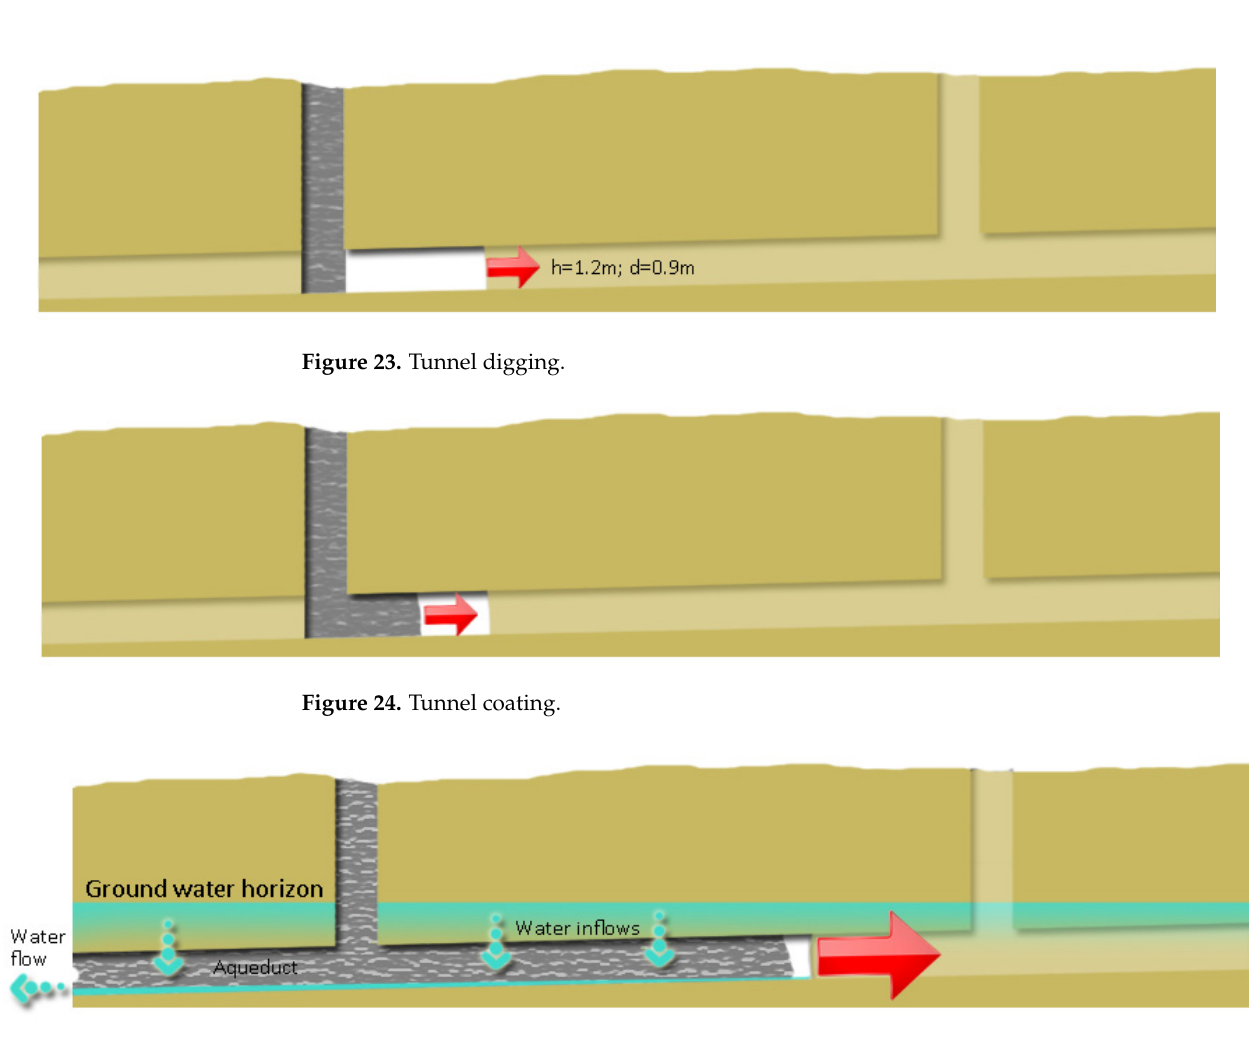
Figure 22. Well coating.